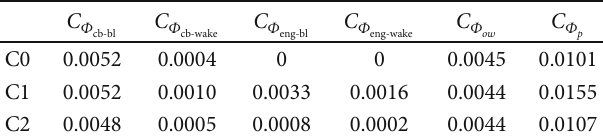
Φ p decomposition.